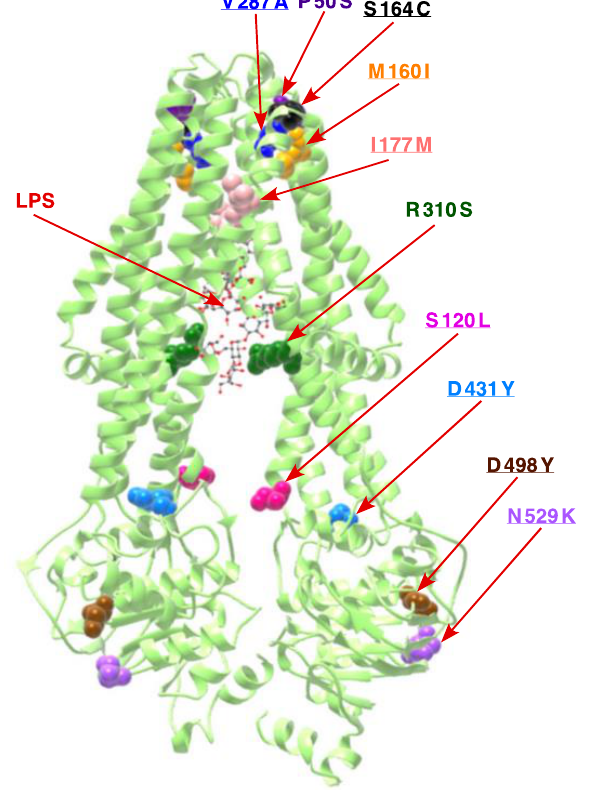
Figure 3. Positions of various single-amino-acid substitutions in the structure of MsbA (PDB 6BPL) [44]. Note the location of R310 in the TM6, which is lined with positively charged and polar residues, and could interact with negatively charged groups in the LPS. The position of the LPS is shown by the arrow. P50 residue is located in the putative lipid-A-binding site on the outer surface of MsbA, and could be in the pathway of lipid A release. The positions of the remaining eight single-amino-acid substitutions that rescue the conditional lethality of ∆ ( lpxM clsA ) are underlined.